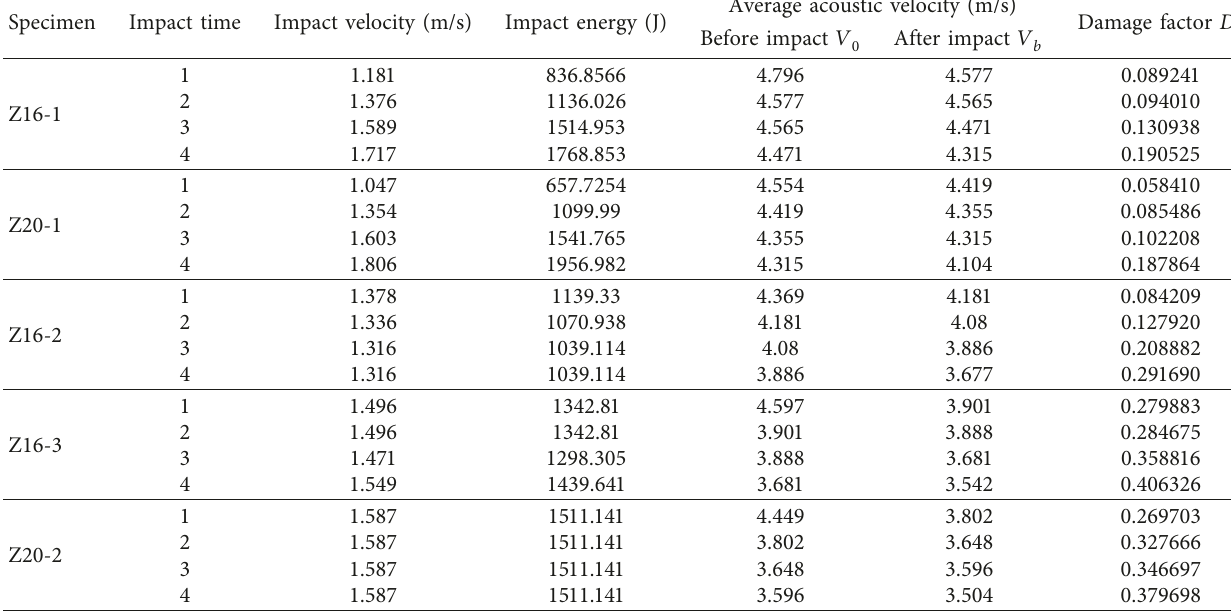
Table 9: Identification of the pier damages using the ultrasonic velocities of the test columns.